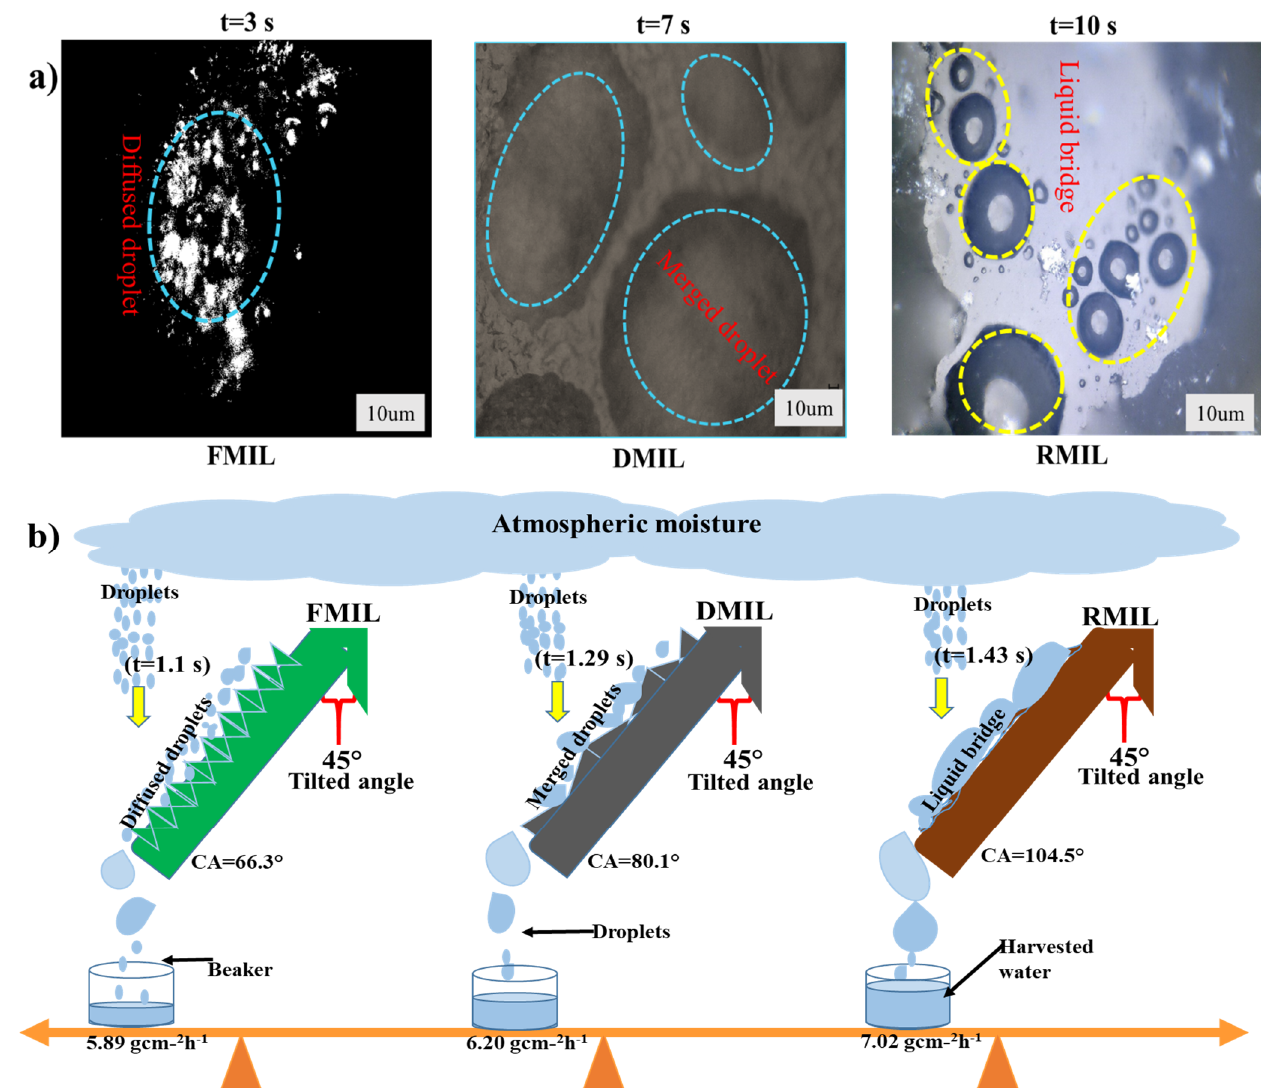
Figure 5. Microscopic and schematic illustration of the atmospheric water collection on various wettable surfaces ( a ) VHX- images displaying the coalescence behavior with respect to time and ( b ) the transportation duration for collection with respect to time; namely; Fresh Mangifera indica leaf (FMIL), Dry Mangifera indica leaf (DMIL), and Replicated Mangifera indica leaf (RMIL).